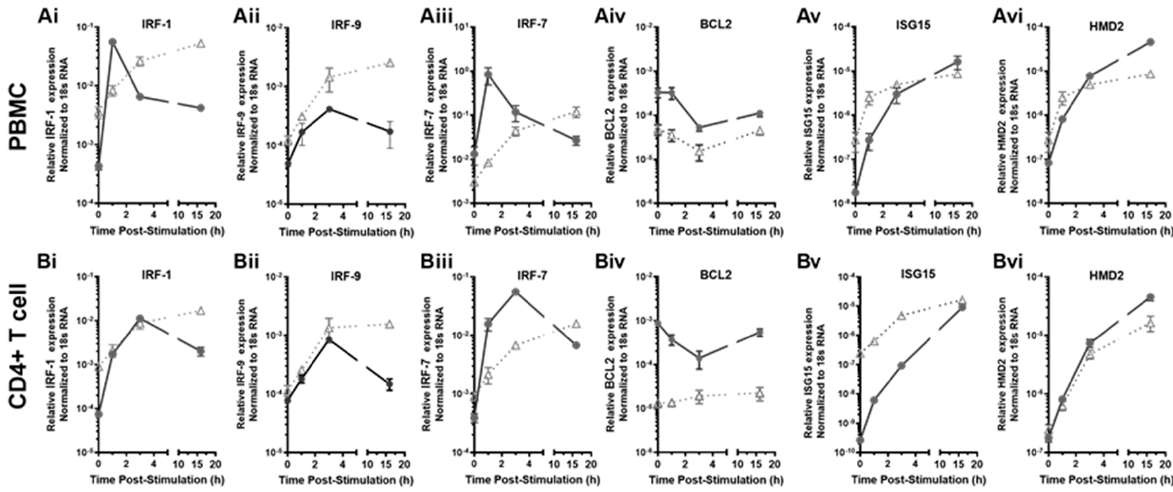
Figure 6. The kinetics of the transcription of ISGs in PBMC and CD4+ T cells in response to exogenous IFN-a2. ( A panel) PBMC and ( B panel) enriched CD4+ T cells from the HESN ( • n = 12) and the non-HESN ( (cid:52) , n = 10) study participants were stimulated with IFN-a2 (10 ng/mL). Total RNA was isolated at the indicated time, following stimulation. Levels of nascent transcripts of ( Ai , Bi ) IRF-1, ( Aii , Bii ) IRF-9, ( Aiii , Biii ) IRF-7, ( Aiv , Biv ) BCL2, ( Av , Bv ) ISG15, and ( Avi , Bvi ) HMD2 were assessed using RT-qPCR and normalized to 18S rRNA levels.